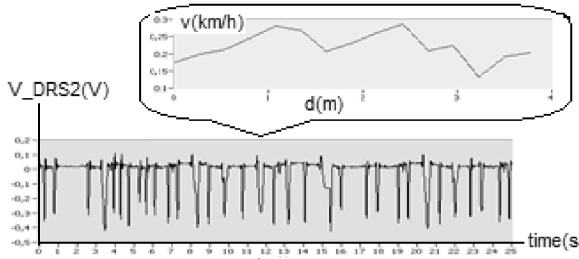
Figure 9. The evolution of the normalized voltage signal acquired from DRS2 measuring channel of the wheelchair and the corresponding velocity variation.